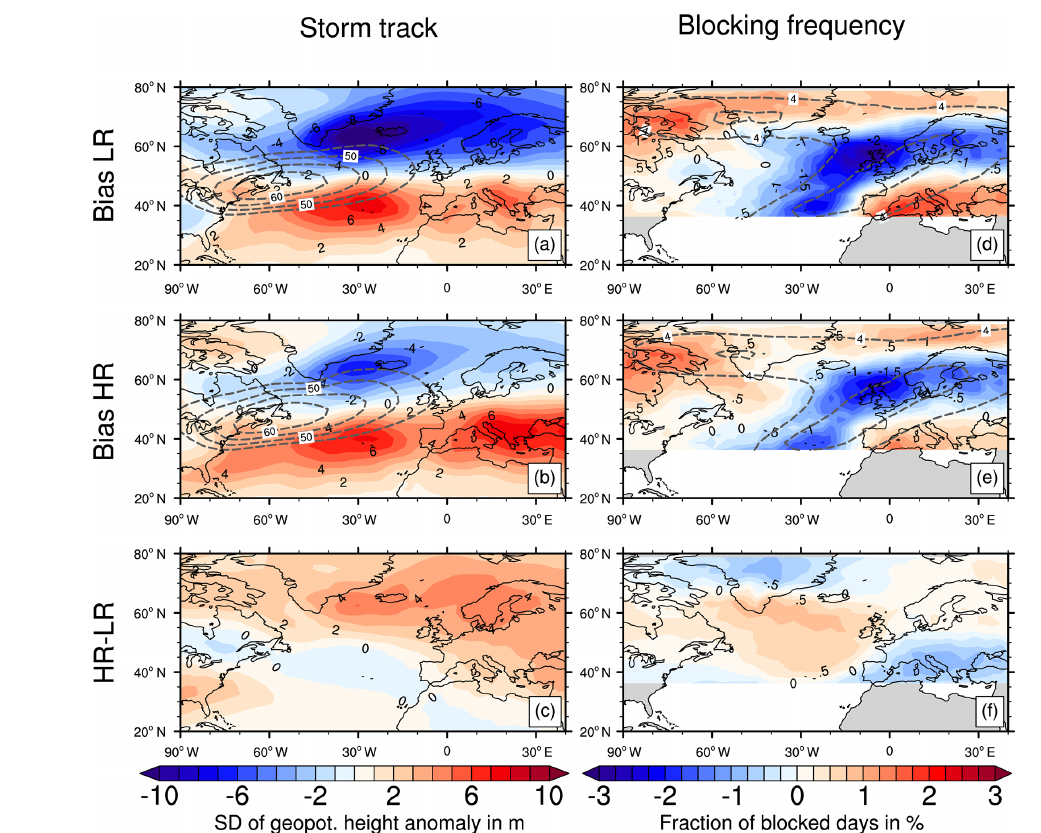
Figure 2. Ensemble mean model bias relative to ERA-Interim (shading) and model climatology (dashed contours) of the respective circu- lation quantity in LR (a, d) , HR (b, e) , and the difference between HR and LR (c, f) . The circulation quantities displayed are the storm track (a–c) and the blocking frequency (d–f) . Initializations from the period 1978–2012 are used for five members of each LR and HR, and the ensemble mean is computed from lead time averages over the hindcast winters 2–5 (October–March). In ERA-Interim the winters between 1979/80 and 2016/17 are used. The grey contours, i.e., ensemble mean climatology, have the same levels as in Fig. 1: 45–60 by 5m for the storm track and 4–8 by 2% for the blocking